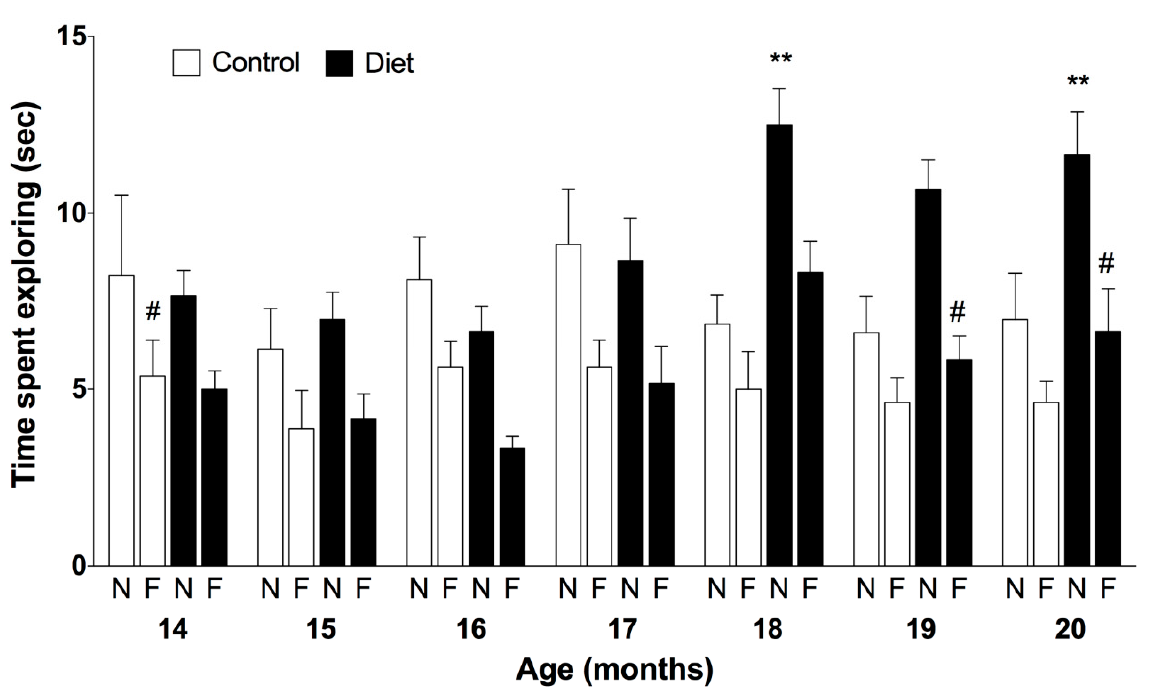
Figure 2. Episodic memory along the chronic treatment assessed by the novel object recognition test. Bars represent the mean ± SEM of time spend (in seconds) exploring the novel and the familiar objects during the test in seconds in animals fed with the experimental diet ( n = 6) and control group ( n = 8). Three-way ANOVA was followed by Bonferroni post-hoc test for the statistical analysis. Three-way ANOVA detected a significant effect for the treatment F(1,168) = 7.87, p = 0.0056; age F(6,168) = 3.027, p = 0.0078 and objects F(1,168) = 55.51, p < 0.0001; ** p < 0.01 when compared novel object in the treated group vs. novel object in the control group at the same age point by Bonferroni post-hoc test; # p < 0.05 when compared novel vs. familiar object in the treated group at 19 and 20 months by Bonferroni post-hoc test.